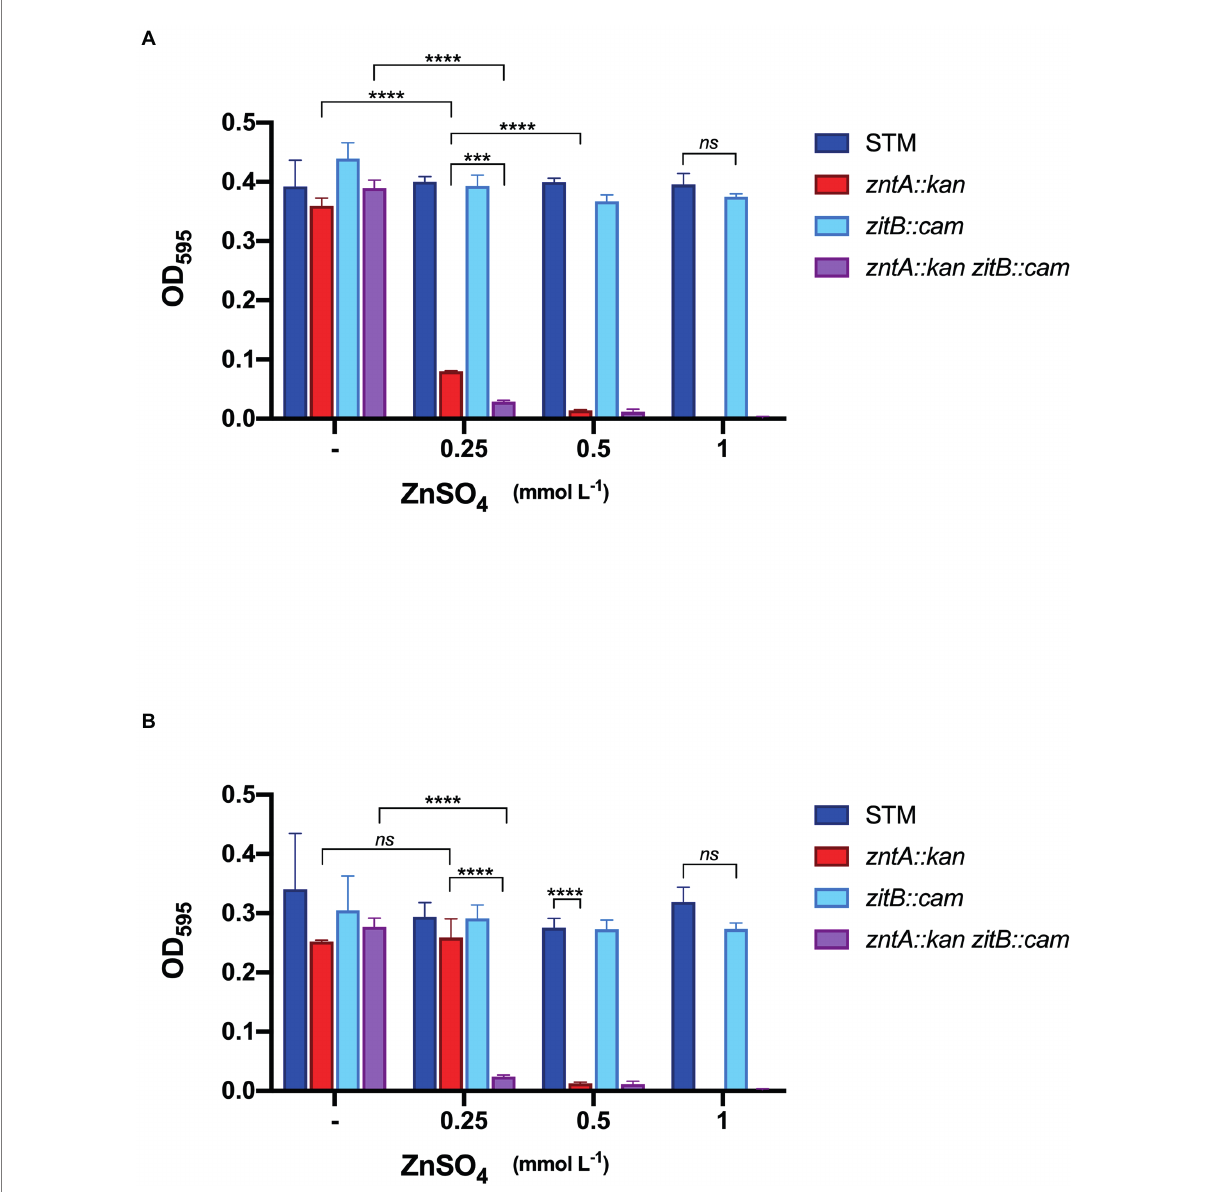
FIGURE 5 In vitro sensitivity of STM and mutants to Zn. Salmonella strains were grown in Vogel Bonner Minimal Medium (VBMM) supplemented with increasing concentrations of ZnSO 4 as indicated. Optical densities at 595 nm were recorded after 9 h (A) and 18 h (B) . Each bar represents the mean value, and statistical significances are calculated by Two-way ANOVA and Tukey’s multiple comparison test (*** p < 0.005; **** p < 0.0001; and ns, not significant). Only significative differences between bars discussed in the text are shown; the overall statistical results are reported in Supplementary Table S2. The graphs are representative experiments of three independent